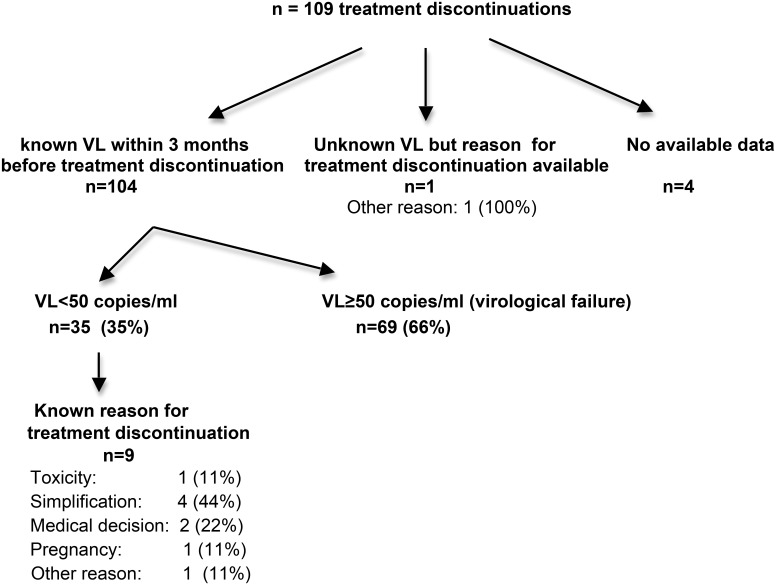
Discontinuations.